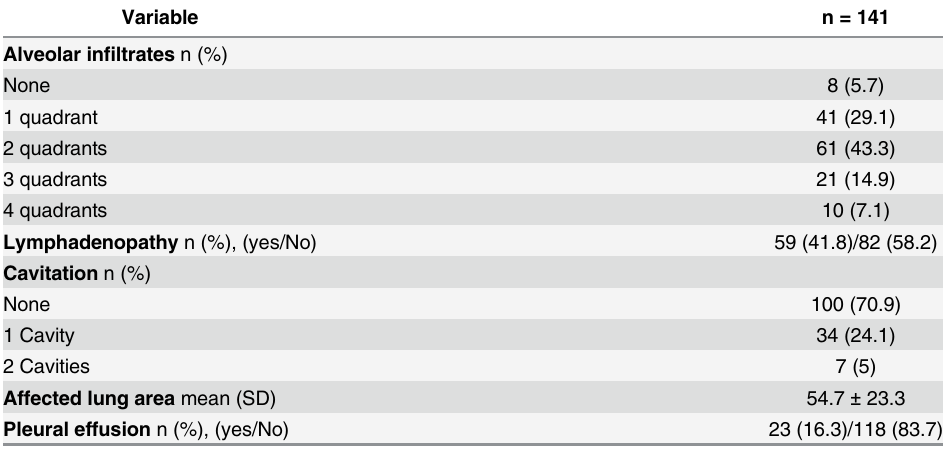
Table 2. Specific Chest Radiograph (CXR) features of lung involvement.